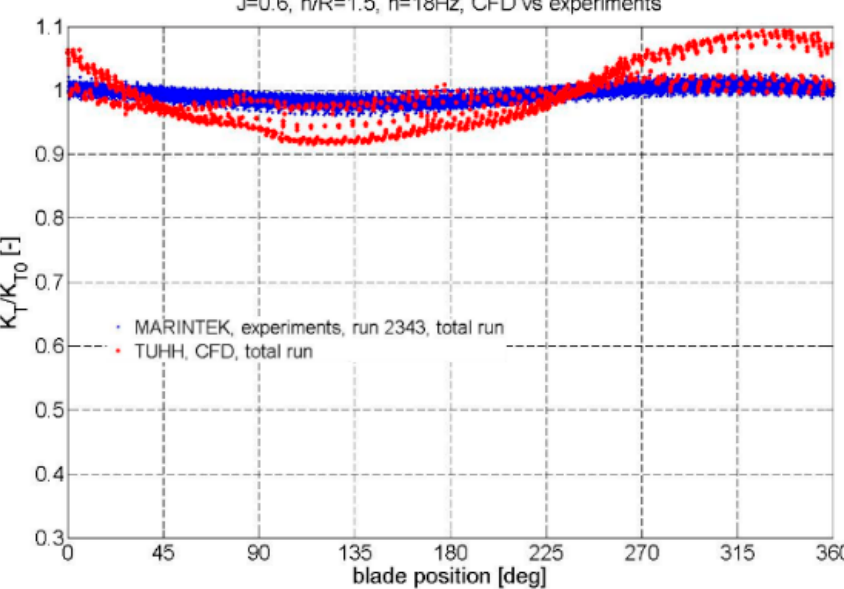
Figure 13. Thrust loss factor as a function of blade position red markers correspond to CFD calculations, and blue markers correspond to experimental results ( Koz10 ).